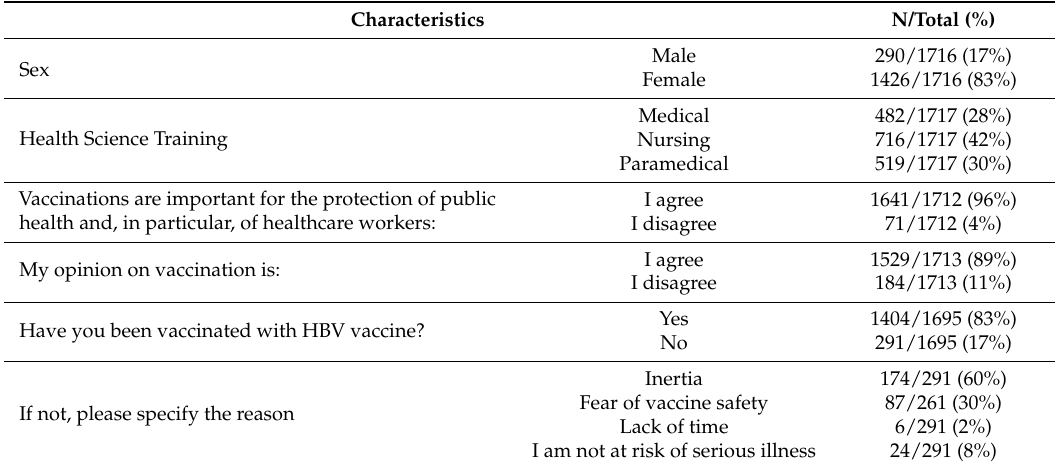
Table 1. Characteristics of healthcare workers and attitudes towards HBV vaccination.